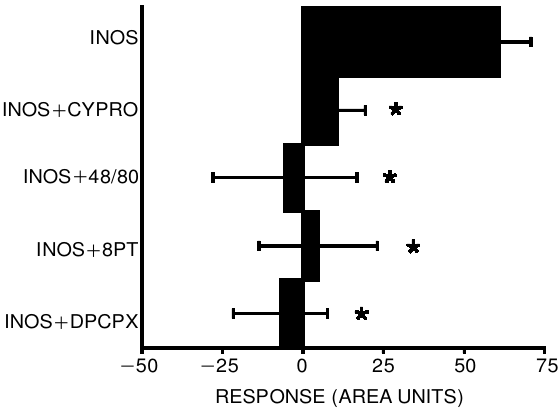
FIG. 2. The vasopressor effect of inosine (2.7 mg) in the rat hind limb, and its modi® cation by pre-treatment